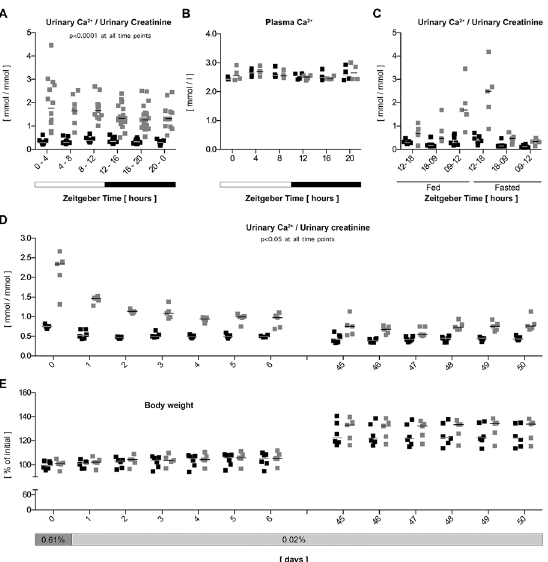
Fig 3. Usp2 -KO mice have hyperabsorptive hypercalciuria. A: Mice were housed in individual metabolic cages and urine was collected every four hours around the clock. Ca 2+ excretion was calculated as a ratio to creatinine. B: Plasma was collected every four hours around the clock and total Ca 2+ was measured. C: Mice were housed in individual metabolic cages with ad libitum feeding or fasted. Urine was collected at the end of the indicated time periods and Ca 2+ excretion was calculated as a ratio to creatinine. D, E : Mice housed in individual metabolic cages were fed a 0.61% Ca 2+ control diet and were then switched to a 0.02% Ca 2+ diet for 6 days. The same animals were then tested again after 45 days of 0.02% Ca 2+ diet for 6 more days. Metabolic parameters were measured every 24 hours and Ca 2+ to creatinine ratio and body weight were plotted. Data are presented as individual values. Black dots: WT, gray dots: Usp2 -KO, bar = median, n = 12 – 18. ( A ), n = 4 ( B ), n = 5 – 7 ( C, D, E ).